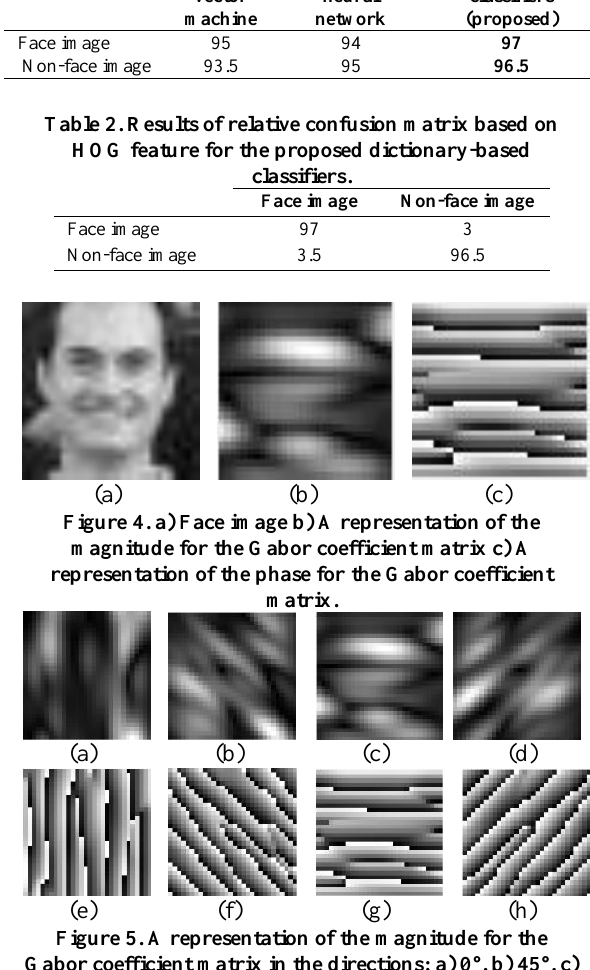
Dictionary-based classifiers (proposed)